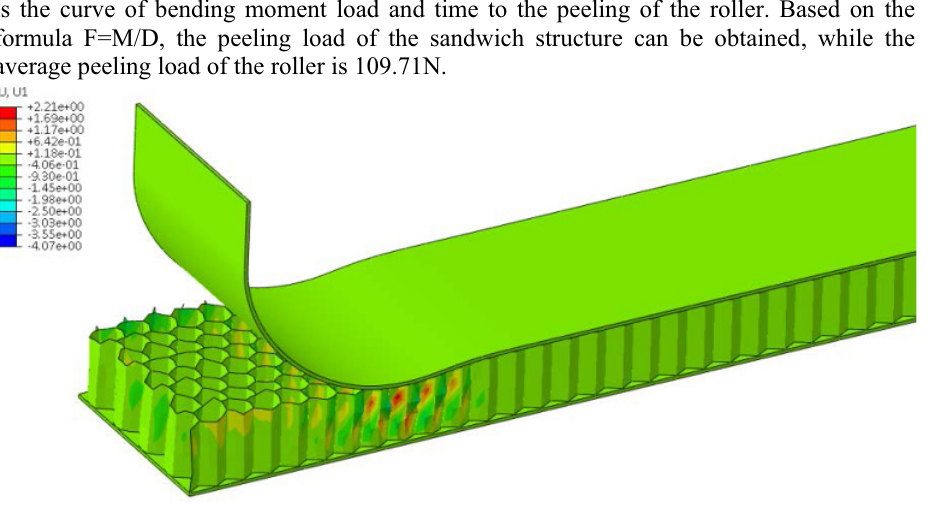
Fig. 5. Vertical deformation cloud image of the sandwich structure.